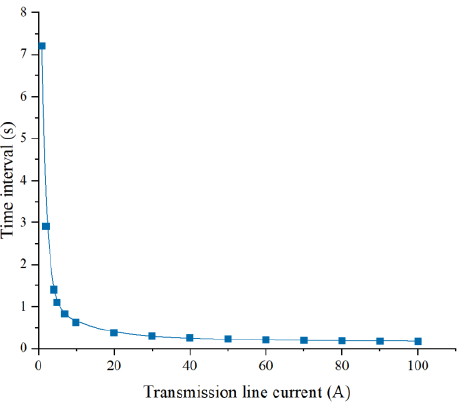
Figure 16. The time interval between the measurements against the transmission line current. Table 2. Calculated primary side current (unit: A).